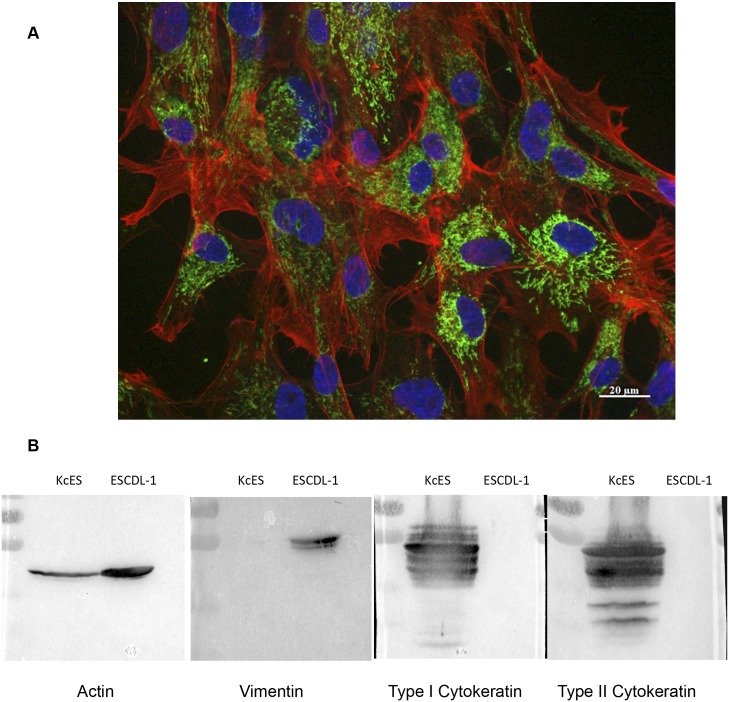
Characterization of ESCDL-1.(A) ESCDL-1 cells (passage 52) display a mesenchyme cell morphology with numerous actin stress fibres (Alexa Fluor® 594 phalloidin). Nuclei appear in blue due to Hoechst 33342 staining, mitochondria in green by staining with monoclonal antibody 4C7 and Alexa Fluor® 488 anti-mouse IgG. (B) ESCDL-1 express vimentin as a major intermediate filament protein. Proteins were extracted from chicken keratinocyte line K8 (KcES) and ESCDL-1 and western blots were probed with anti-actin JLA-20, anti-vimentin AMF17b, or anti-cytokeratin type I or II antibodies. The apparent molecular masses of actin (45 kDa) and vimentin (55 kDa) are similar to those described in the publications describing the monoclonal antibodies. ESCDL-1 cells do not express type I or II cytokeratins, which are detected in KcES extracts. Molecular weight markers (PageRuler™ Plus prestained protein ladder—Thermo Scientific) are on the left side of each blot.